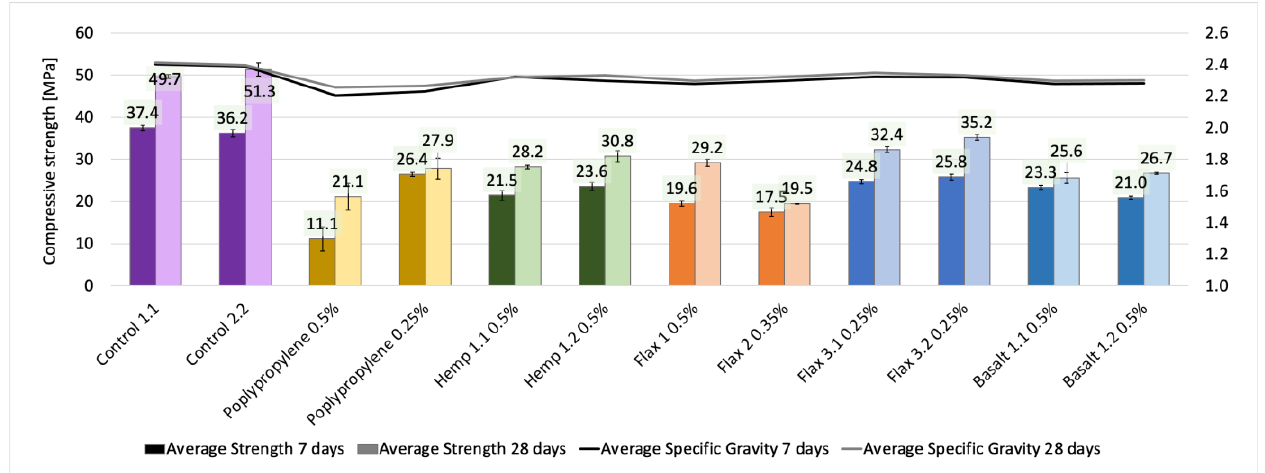
Figure 16. Compressive strength [MPa] and specific gravity [g/cm 3